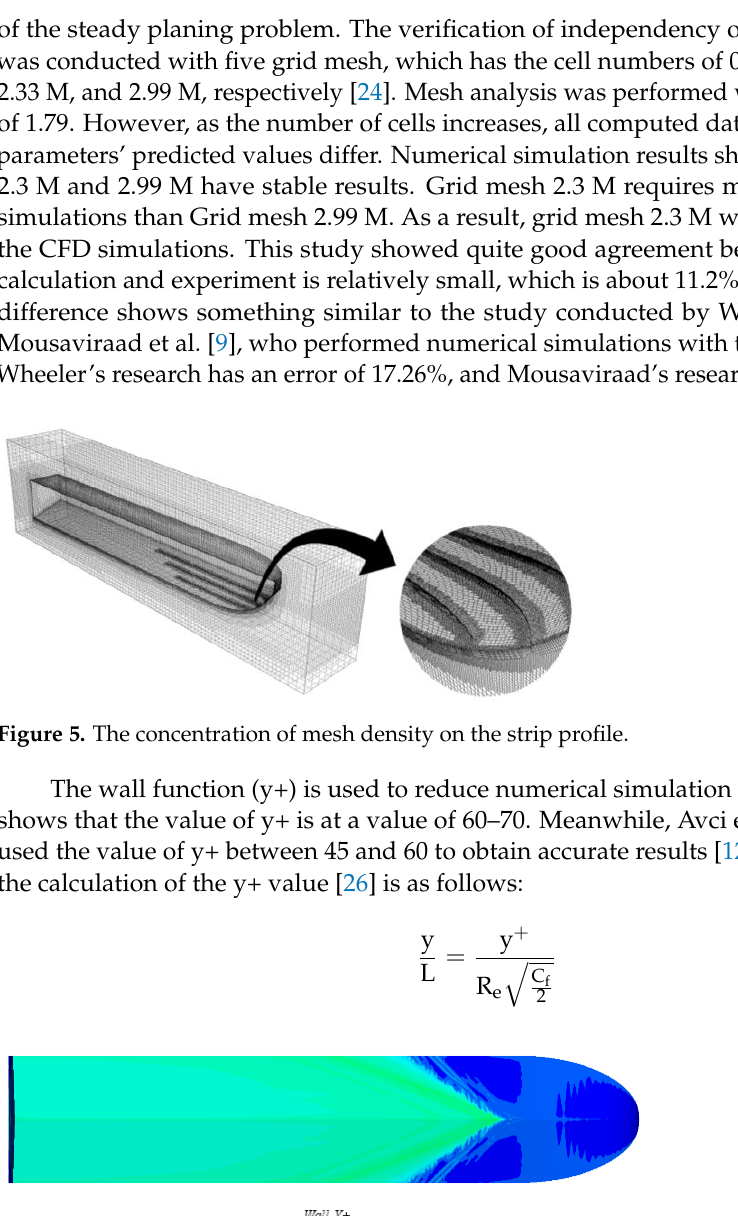
Figure 4. Boundary condition and Fluid domain.